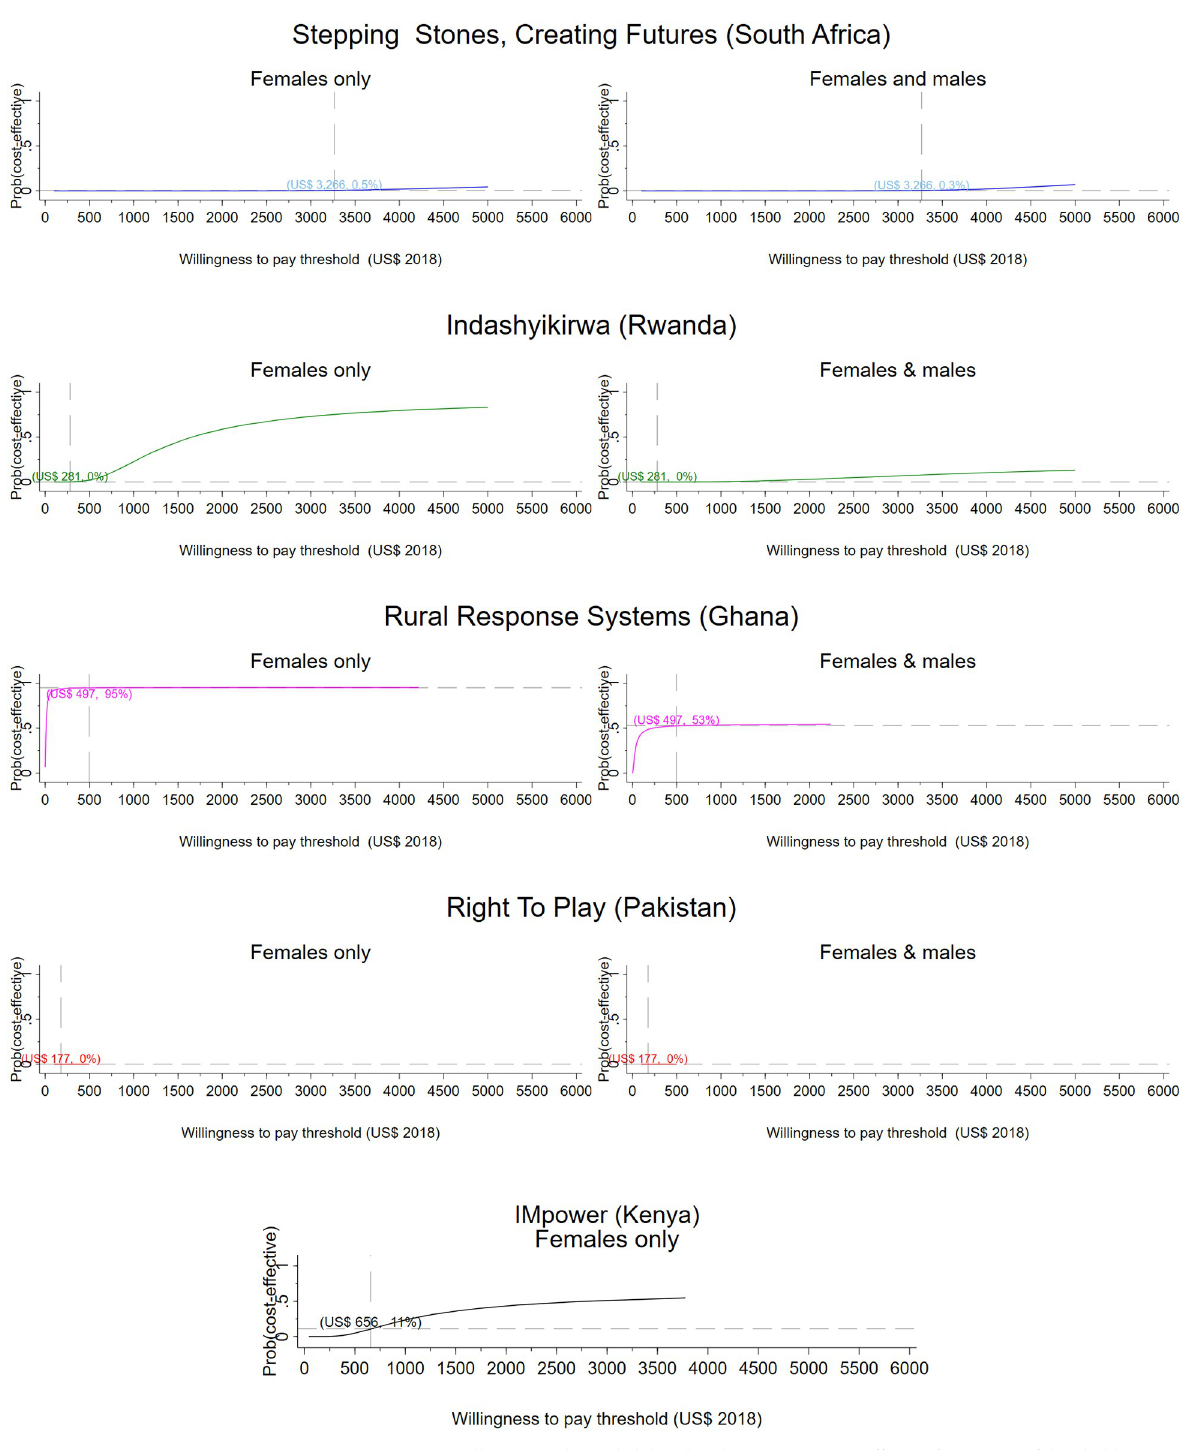
Fig 5. Scale-up scenario 2, provider perspective. CEACs illustrating the probability that the intervention is effective for a range of thresholds. Dashed vertical line: country-specific opportunity cost threshold; dashed horizontal line: probability that the intervention is cost-effective at the country-specific threshold, given the cost per DALY averted by the intervention. DALY, disability-adjusted life year.